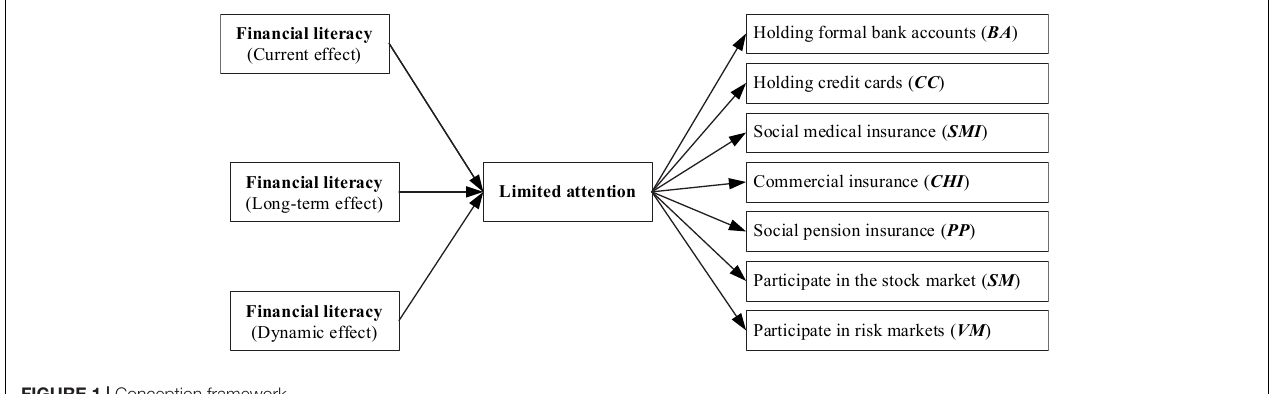
FIGURE 1 | Conception framework.